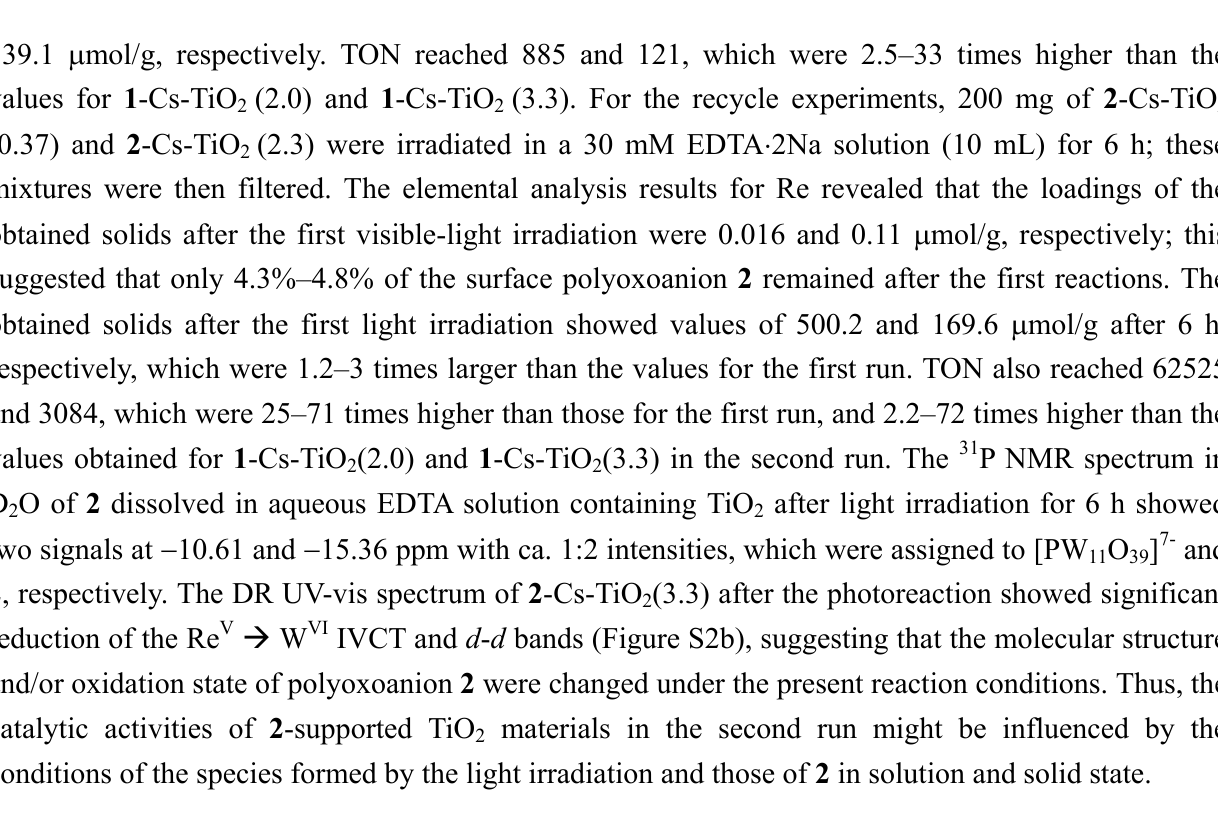
Table 2. Hydrogen evolution from water catalyzed by 2 -supported TiO